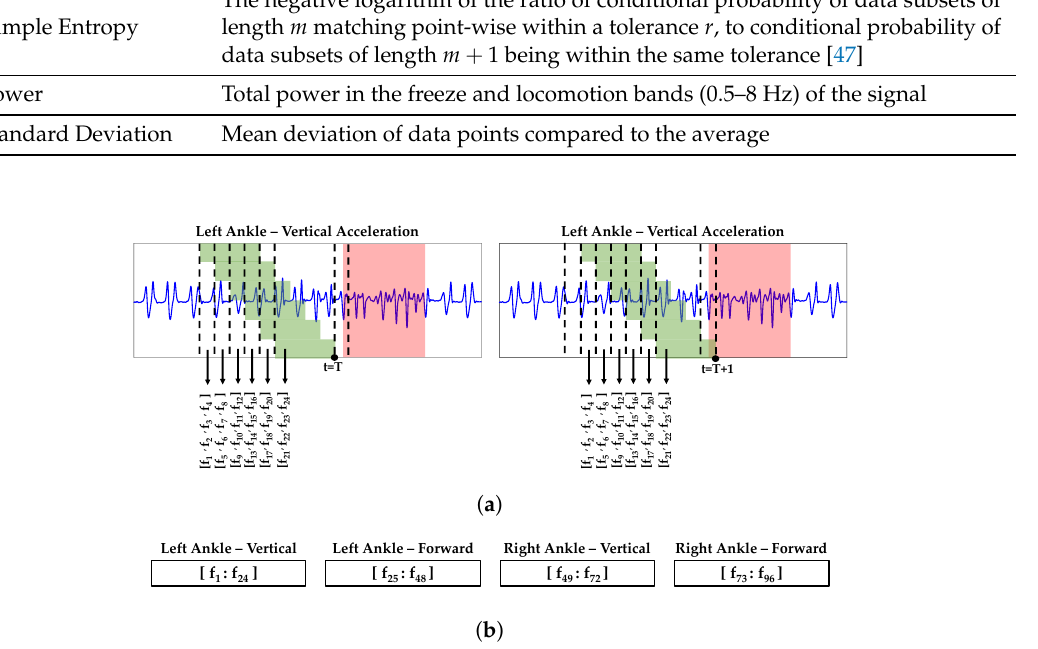
Figure 2. The process of creating samples from acceleration signals. ( a ) Extracting features from six successive windows at time t = T (left) and the next time step, t = T + 1 (right). Red highlighted area shows FoG labeled period using recorded videos, green boxes show length of windows used to extract features from acceleration signal; ( b ) Combining arrays of features from different combinations of